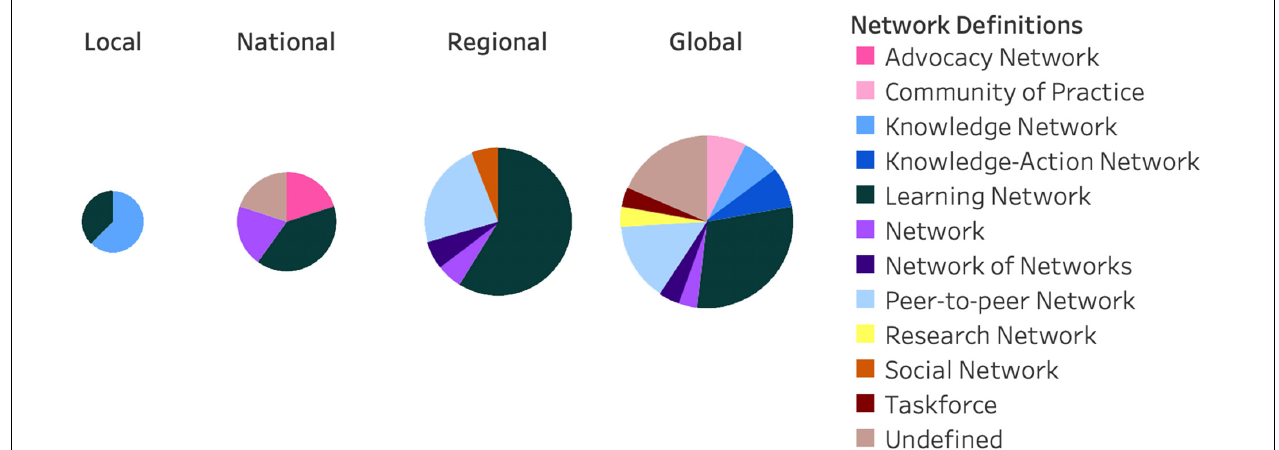
FIGURE 1 | Network definitions that informants in the 16 different networks referred to. The number of informants interviewed from each scale differs: local ( n = 6); national ( n = 4); regional ( n = 13); global ( n = 17). The size of each pie chart indicates the weight that each scale had in the analysis, as determined by a combination of the number of informants interviewed from each scale and the number of networks that those informants represent. This figure shows the diversity in terminology within the various network scales and illustrates that there was diversity in terminology within the networks themselves. Numerous informants from each network used more than one term or definition to describe their